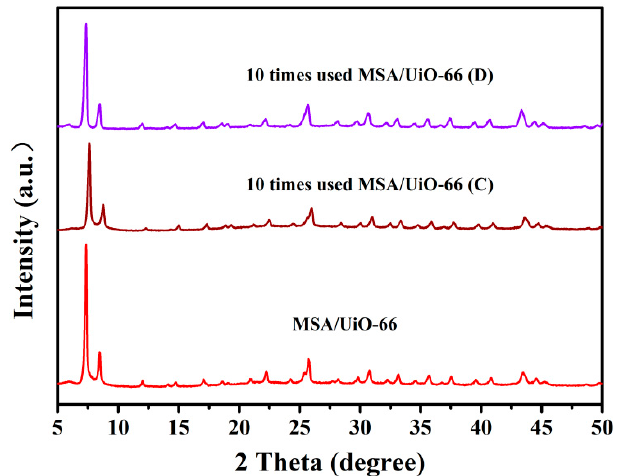
Figure 12. XRD patterns of the used catalyst in the esterification of PA with n -decanol (C) or n -butanol (D).